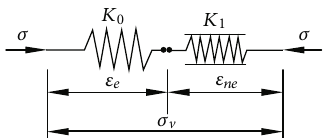
Figure 4: Stress-strain model of broken